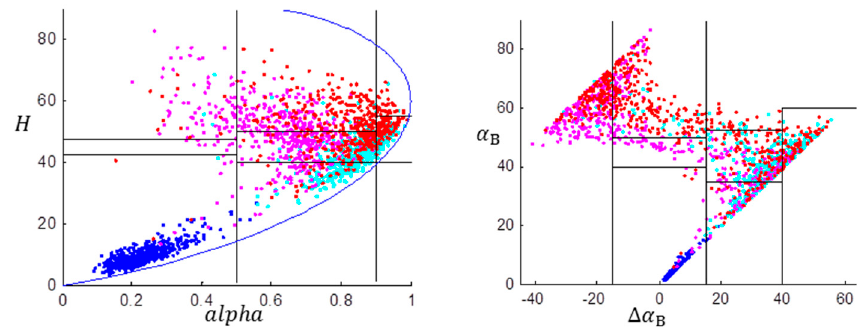
Figure 4. Scatter plots by using ( a ) the GF-3 data and ( b ) the Radarsat-2 data. Blue dots indicate samples from ocean surface, cyan samples from the forest area, magenta samples from the urban area, and red samples from the tilted urban area. Table 1. Classification accuracies (in percentage) of the H / alpha method and the ∆ α B / α B method for four typical regions. The four areas were outlined in Figure 2. z 1 − z 9 are the segmentation zones in both the H / alpha and ∆ α B / α B planes [13]. (A) Results by Using the GF-3 Data